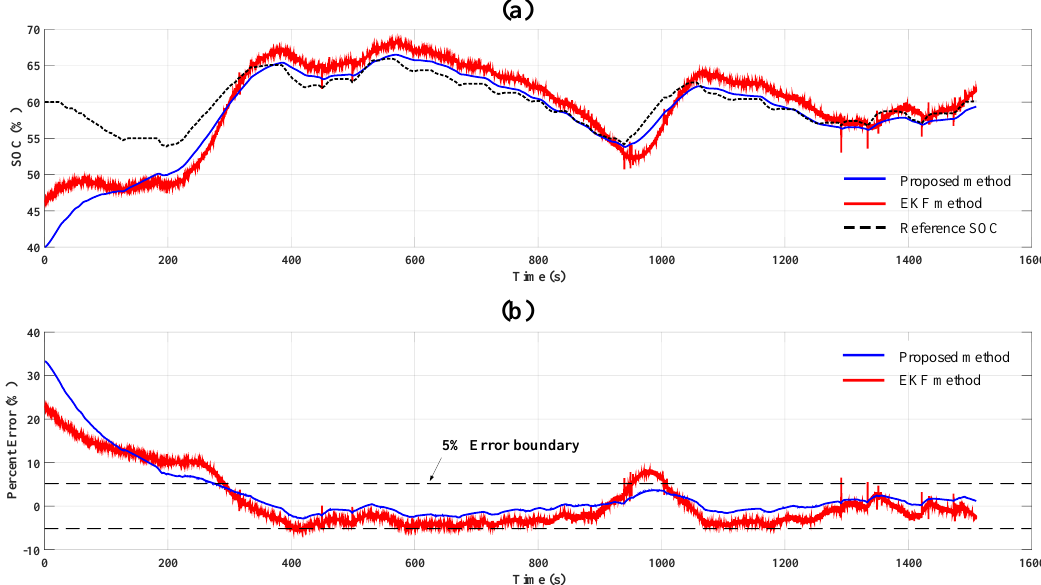
Figure 13. SOC estimation results with voltage and current sensor noise: ( a ) SOC estimation results of the two types of methods and ( b ) percentage error of each method.